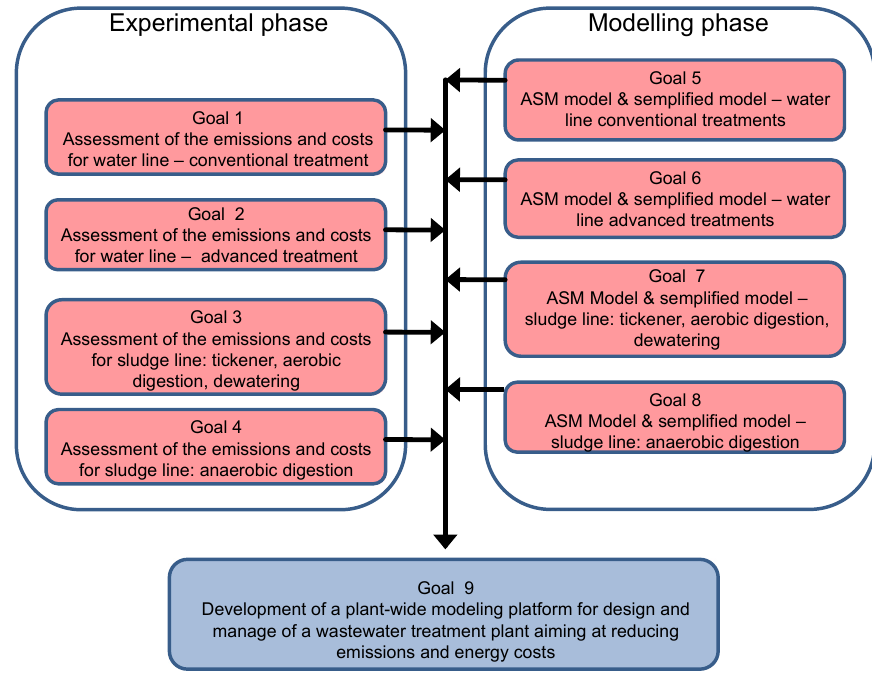
Figure 2. Scheme of the project goals.